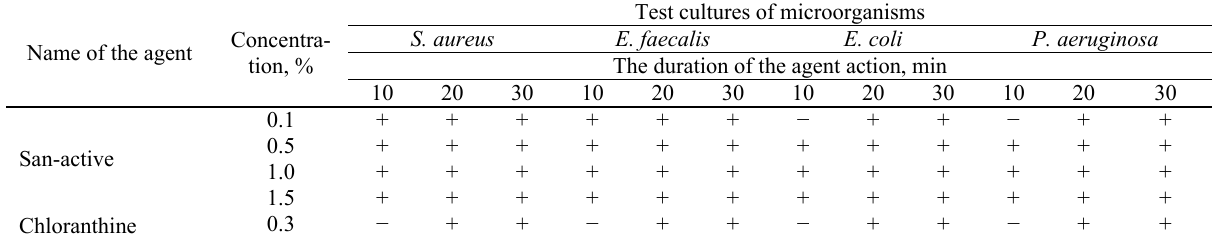
Influence of the “San-active” on the test culture of conditional-pathogenic bacteria in the suspension method, n = 36 Test cultures of microorganisms Concentra- Name of the agent